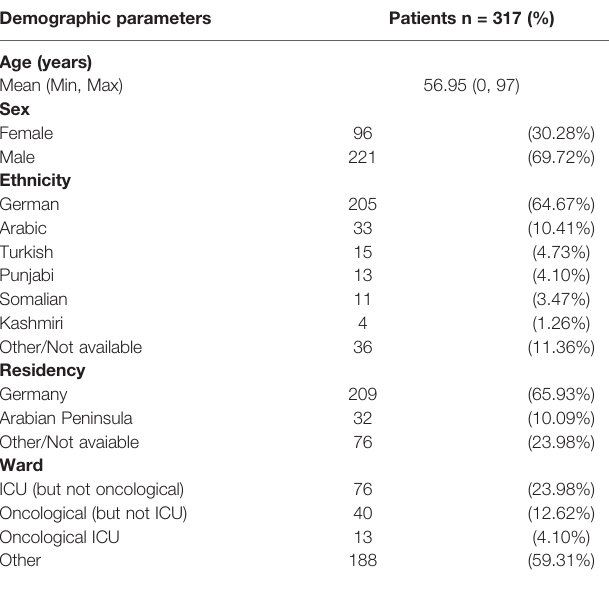
TABLE 1 | Summary demographics for patients with detected CEB isolates. Demographic parameters